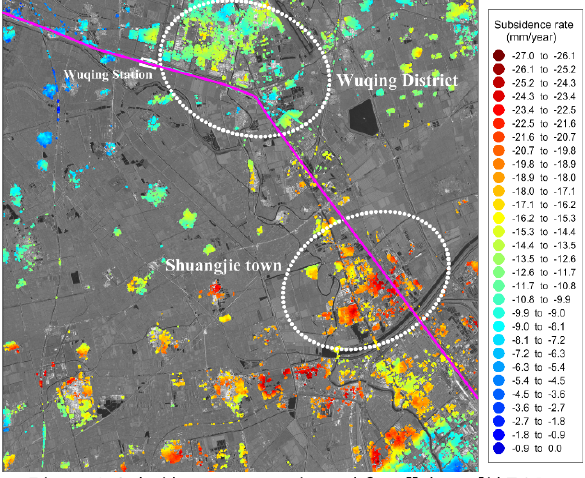
Figure 4. Subsidence rates estimated for all the valid TCPs A High Speed Railway is highlighted by a pink line and the Wuqing Station is located in the southwest of Wuqing District marked by a white hollowrectangle. Two subsidence funnel circled along the railway line can been